Question: In a single sentence, describe what this figure presents.
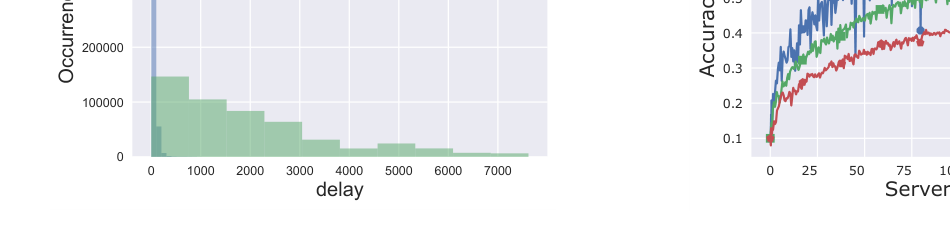
Answer: Histogram of fast and slow delays (in number of server steps) for a uniform sampling scheme.